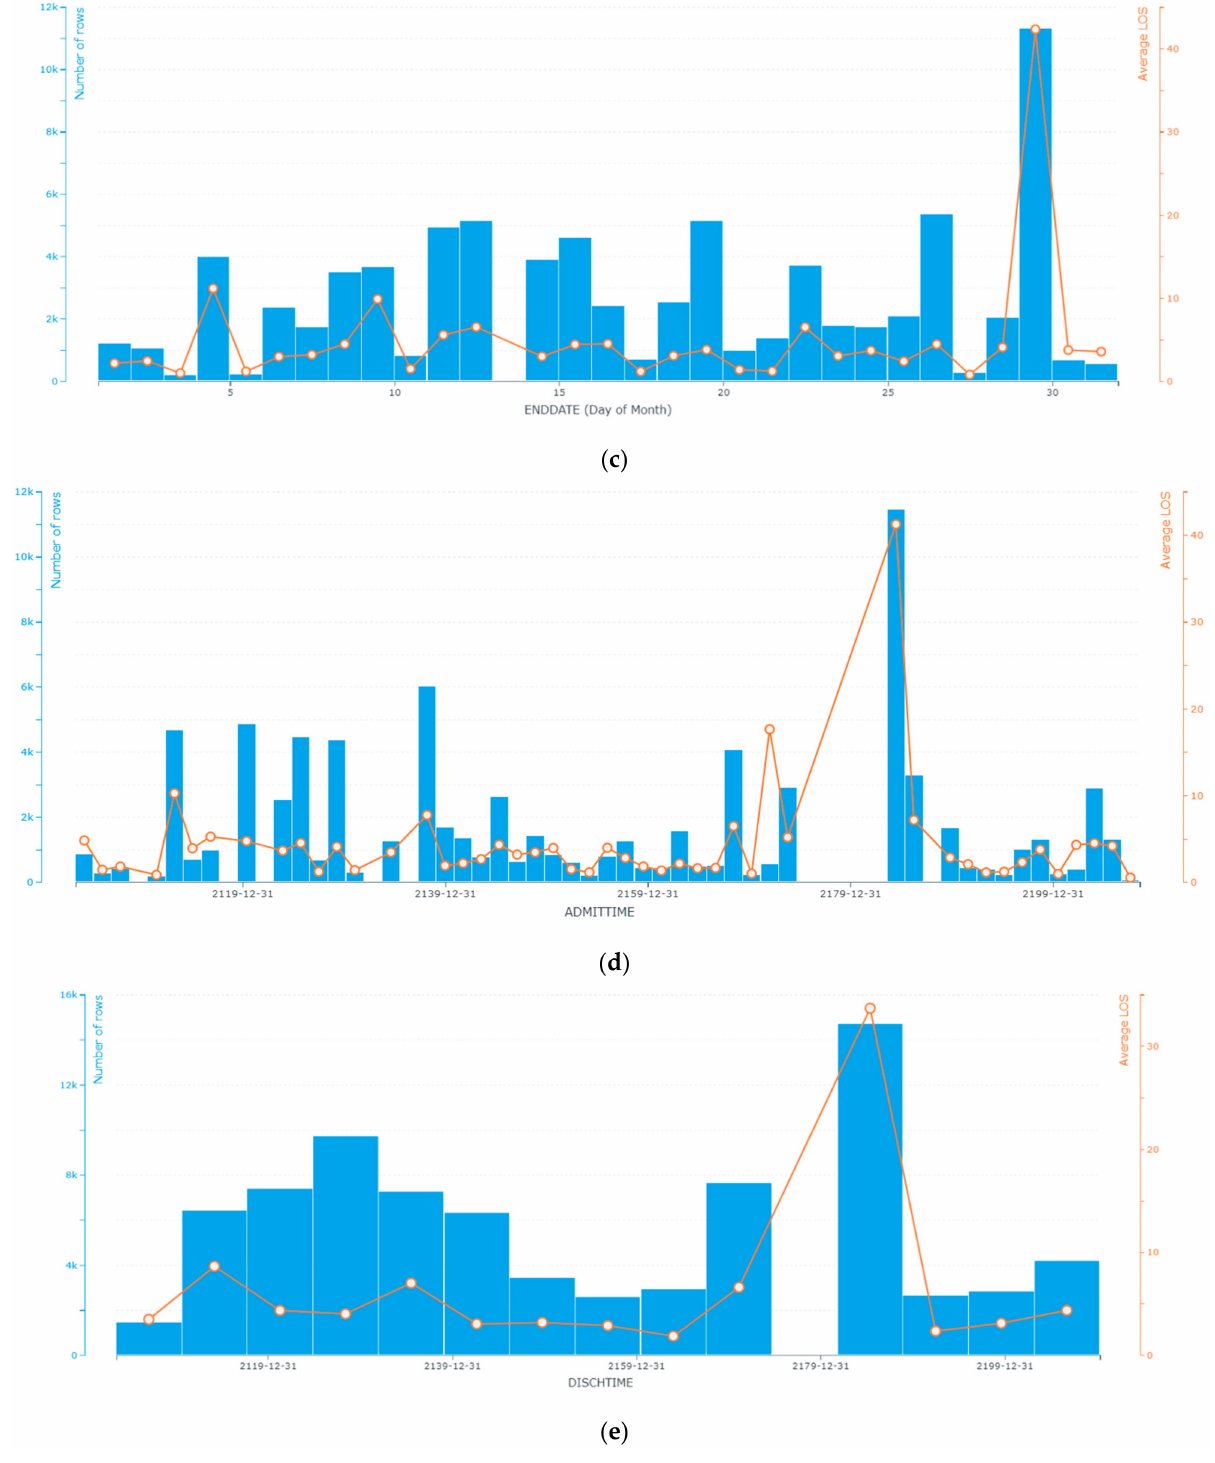
Figure 3. Feature selection of informative features. ( a , b ) represent the correlation between drug dosage and type, and time of discharge, respectively. Figure ( c ) is the time that marks the end of a specified drug therapy. ( d , e ) are the chronological timing of admission to ICUs, and their actual discharge